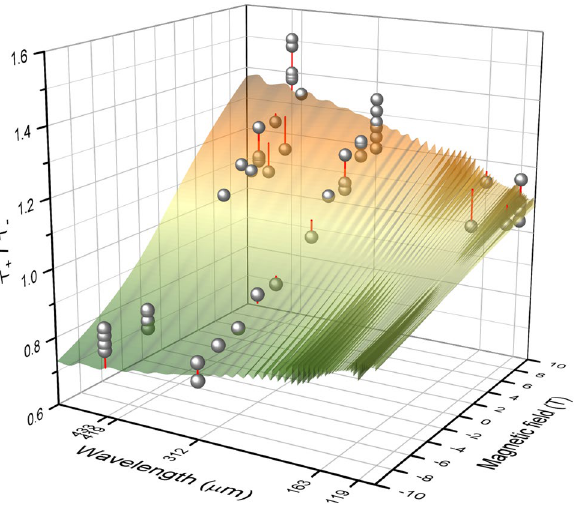
/ T Figure 3. Transmittance ratio T for the laser lines 119, 163, 312, 419, and 433 µ m as a function of + − magnetic field. The theoretical prediction (colored surface) with no free fitting parameter is compared with experimental values (spheres) observed at a temperature of 45 K. The corrugation of the theoretical surface results from interference in the film/substrate structure. Its amplitude is smaller than the experimental error. The values observed under identical conditions but in different runs hang on the same vertical line attached to the surface. These repeated measurements demonstrate a spread of the experimental data. Despite the experimental uncertainty, the overall magnitude and dependence on magnetic field and wavelength are consistent with the Kopnin–Vinokur